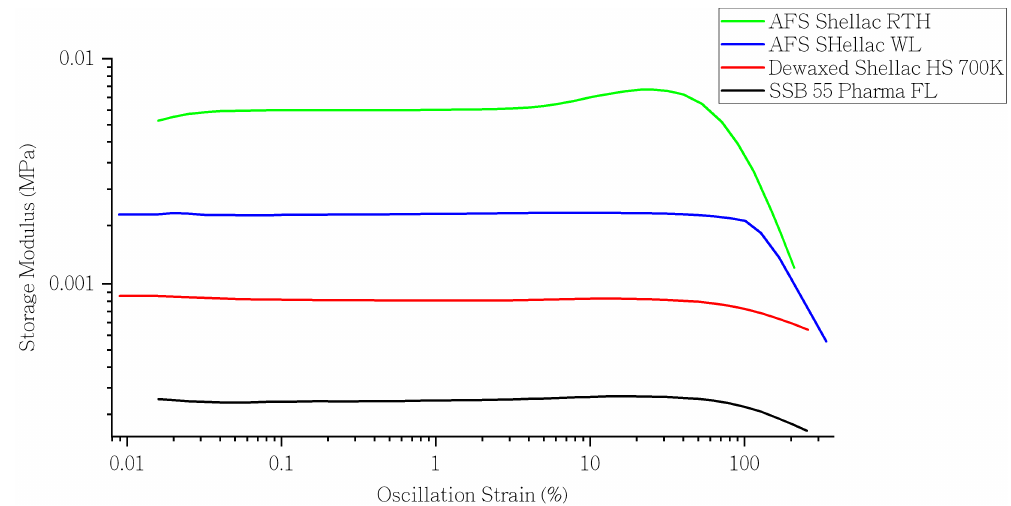
Figure 2. The storage modulus of various shellac materials versus oscillation strain (%) in amplitude sweep at 90 ◦ C. Table 3. The linear viscoelastic region of shellac at various temperatures.